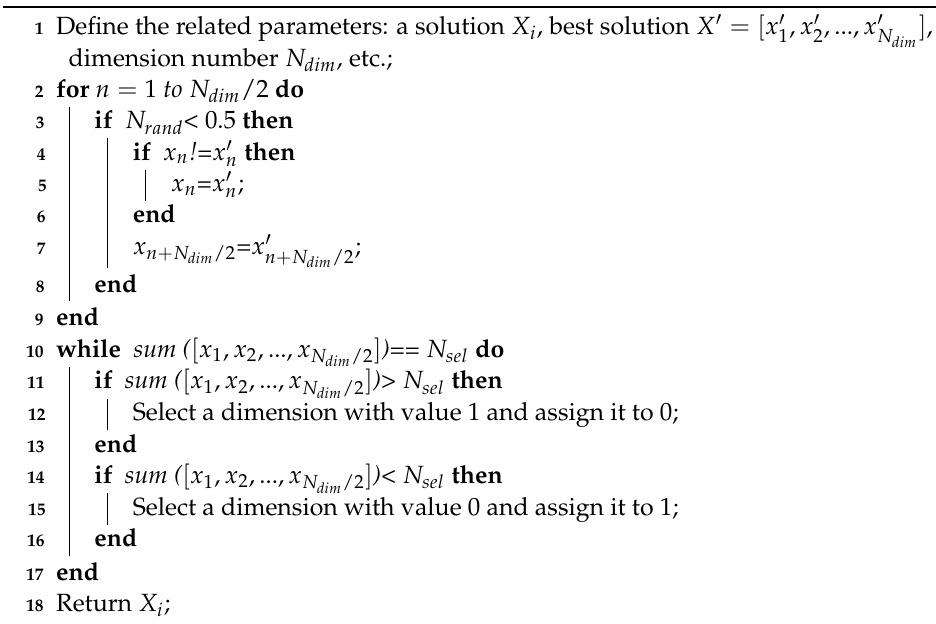
Algorithm 1: Hybrid Solution